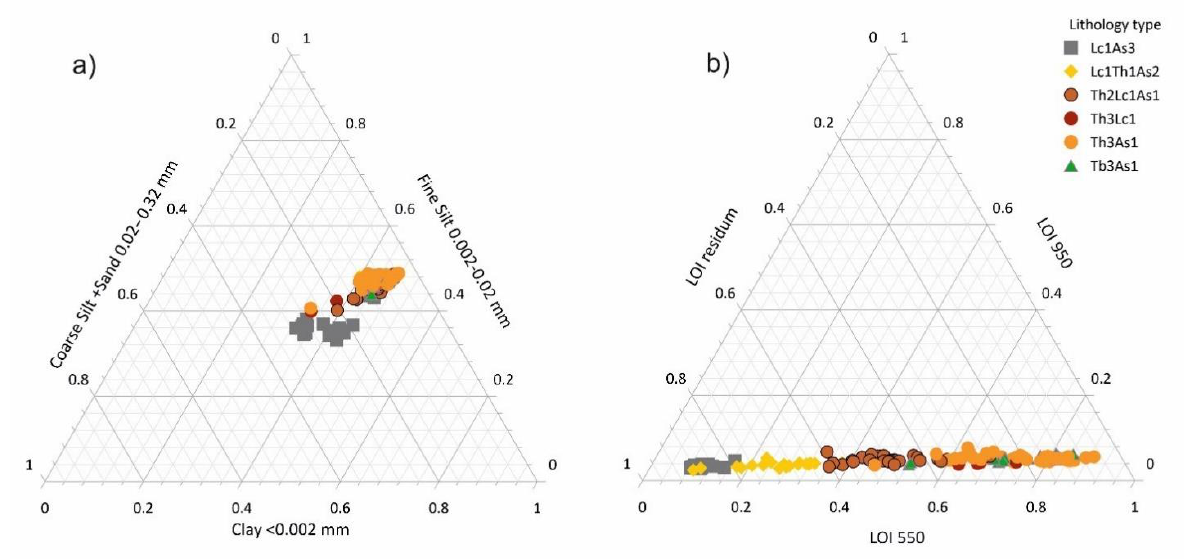
Figure 5. ( a ) The grain-size composition shown on a triangle diagram for each sample in lithology type. ( b ) LOI550, LOI950 and LOI residum shown on a triangle diagram for each sample in lithology type.